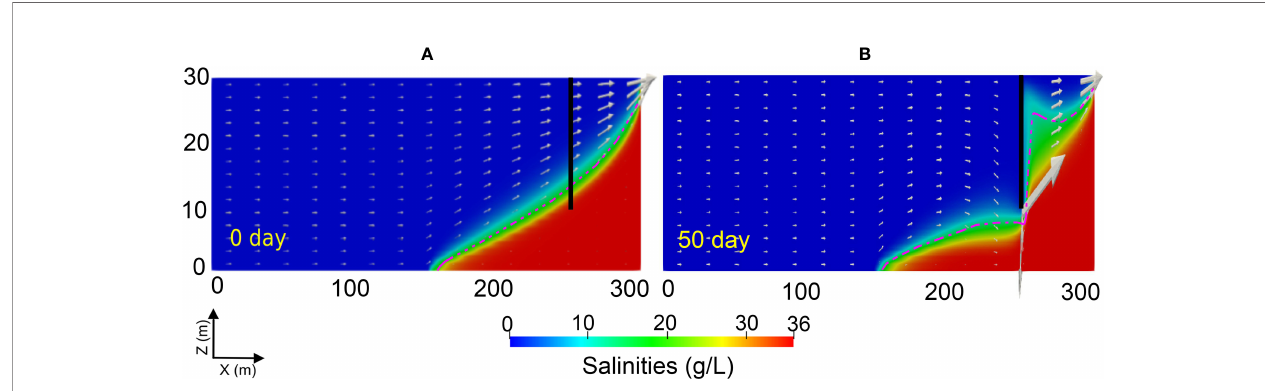
FIGURE 6 | Transient distributions of groundwater fl ow and saltwater wedge after the construction of a 25 m-depth cut-off wall at 50 m from the seaward boundary at 0 day (A) and 50 days (B) . The vertical black lines indicate the installed cut-off wall, the red dotted lines represent the isolines of 50% salinity of the saltwater, the white arrows represent the magnitude and direction of groundwater